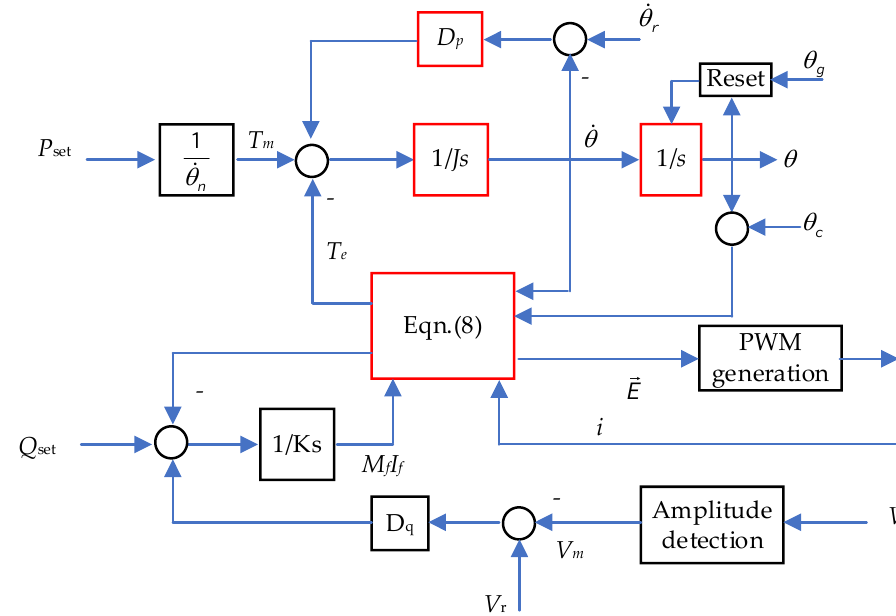
Figure 3. Block diagram of the control principle.